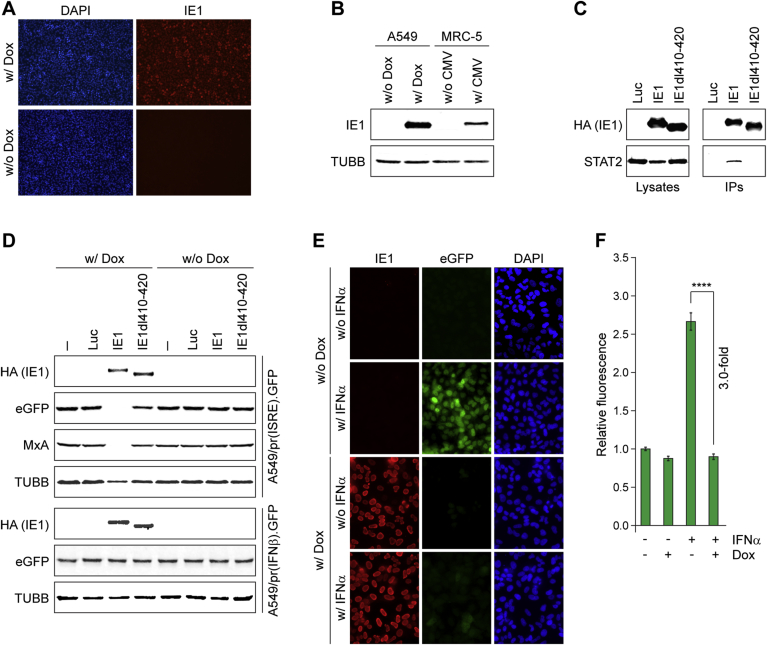
Characterization of the A549/pr(ISRE).GFP-IE1 reporter cell-line. (A) Immunofluorescence analysis of IE1 expression. A549/pr(ISRE).GFP-IE1 cells were treated with doxycycline for 24 h (w/Dox) or left untreated (w/o Dox). Paraformaldehyde-fixed samples were examined for IE1 expression using mouse anti-IE1 and Alexa Fluor 594 goat anti-mouse antibodies. Staining with 4′,6-diamidino-2-phenylindole (DAPI) was performed to visualize nuclei. (B) Western blot analysis of IE1 expression. A549/pr(ISRE).GFP-IE1 cells (A549) were treated with doxycycline for 24 h (w/Dox) or left untreated (w/o Dox), and MRC-5 fibroblasts were infected with gTBwt (MOI = 1 PFU/cell) for 24 h (w/CMV) or left uninfected (w/o CMV). Whole cell extracts were prepared, and IE1 and β-tubulin (TUBB) steady-state protein levels were analyzed by SDS-PAGE/Western blot. (C) Complex formation between IE1 and STAT2. A549/pr(ISRE).GFP cells with inducible expression of Luc, HA-tagged IE1 or HA-tagged IE1dl410-420 were treated with doxycycline for 48 h. Whole cell extracts were prepared and used for immunoprecipitations with anti-HA-agarose. Samples of lysates and immunoprecipitates (IPs) were analyzed by SDS-PAGE/Western blot for IE1 (HA antibody) and STAT2. (D) Western blot analysis of the effects IE1 exerts on IFN signaling and IFN induction. A549/pr(ISRE).GFP and A549/pr(IFNβ).GFP cells without (−) or with inducible expression of Luc, HA-tagged IE1 or HA-tagged IE1dl410-420 were seeded in the presence (w/Dox) or absence (w/o Dox) of doxycycline and treated with IFNα (A549/pr(ISRE).GFP cell-lines) or UV-inactivated, pp65-deficient CMV (A549/pr(IFNβ).GFP cell-lines) for 48 h. Whole cell extracts were prepared and IE1 (HA antibody), eGFP, β-tubulin (TUBB) and MxA protein levels were analyzed by SDS-PAGE/Western blot. (E) Immunofluorescence analysis of the effects IE1 exerts on IFN signaling. A549/pr(ISRE).GFP-IE1 cells were seeded in the presence (w/Dox) or absence (w/o Dox) of doxycycline and treated with IFNα (w/IFNα) or solvent (w/o IFNα) for 24 h. Paraformaldehyde-fixed samples were simultaneously reacted with a rat monoclonal antibody to HA-tagged IE1 and a mouse monoclonal antibody to eGFP, followed by incubation with a rat-specific Alexa Fluor 594 conjugate and a mouse-specific Alexa Fluor 488 conjugate. Host cell nuclei were visualized by DAPI staining. (F) Effect of IE1 expression on eGFP fluorescence intensity upon activation of the IFN signaling pathway. A549/pr(ISRE).GFP-IE1 cells were seeded in the presence or absence of doxycycline and treated with IFNα or solvent for 48 h. Fluorescence intensity was measured using an Infinite-M200-Pro microplate reader. Means and SDs of triplicate samples are shown in comparison to untreated cells (set to 1). Statistical significance was assessed using a two-tailed, unpaired/equal variance T-test; ****, p < 0.0001.